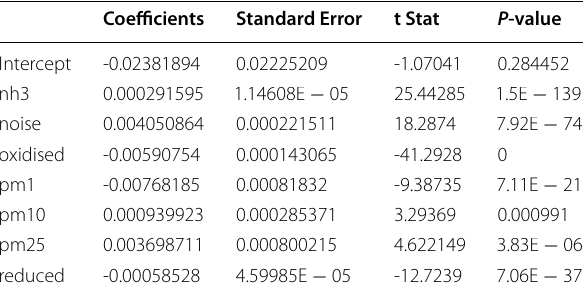
Table 3 Multiple Regression Analysis between EDA and Environmental variables